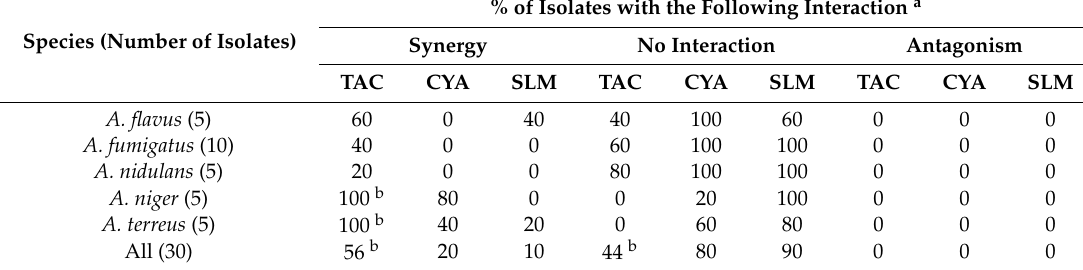
Table 2. Summary of interactions of isavuconazole with tacrolimus, cyclosporin A, or sirolimus against Aspergillus species interpreted based on the fractional inhibitory concentration